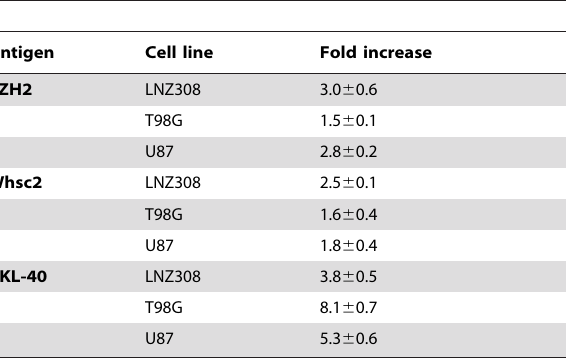
Table 1. Three other human glioma cells make increased mRNA of EZH2, Whsc2 and YKL-40 under hypoxic conditions.